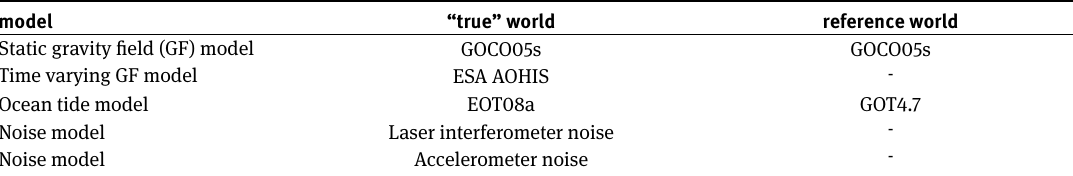
Table 2. Force and noise models of the “true” and reference world used in the full-scale simulations.